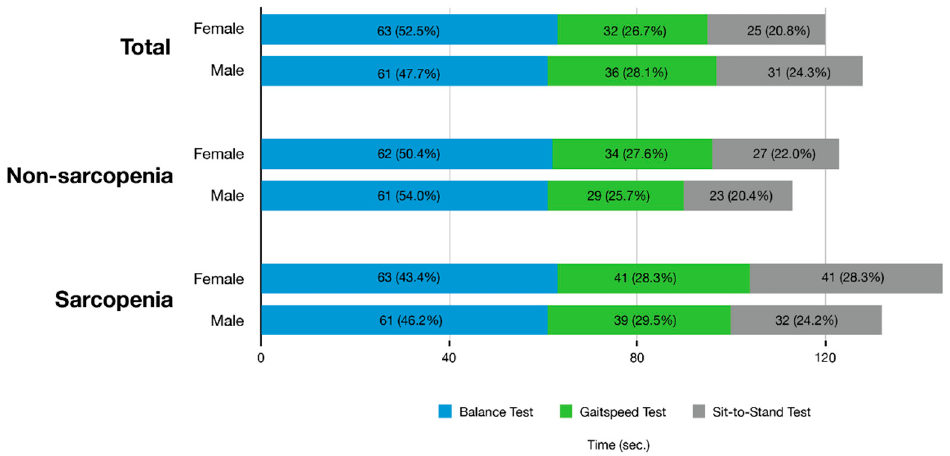
Figure 1. Test time for individual components and the total electronic Short Physical Performance Battery protocol in the study participants with or without sarcopenia.